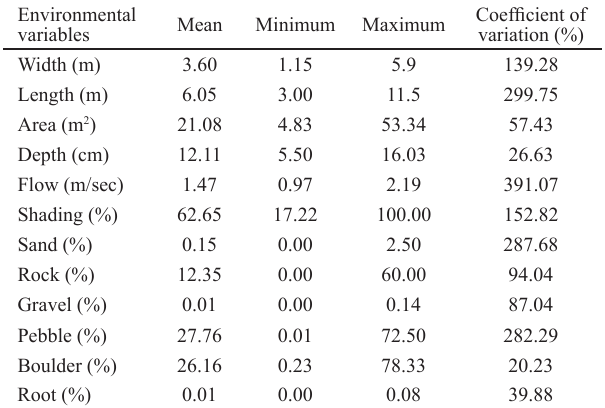
Table 1. Statistical summary of the environmental characteristics of the riffles.